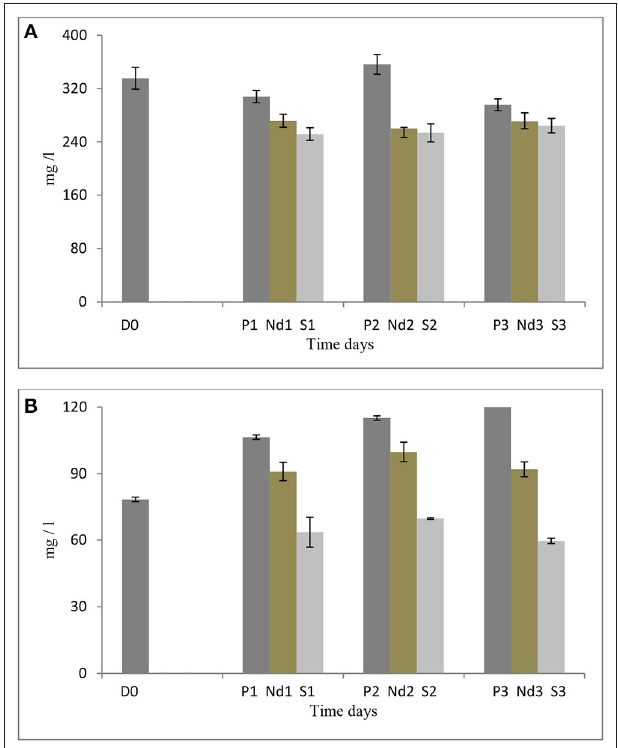
FIGURE 3 | (A) Biomass production of S. dimorphus over time (three days) in prolonged growth, nutrient deprivation and 5% salt stress. (B) Biomass production of S. minutum over time (three days) in prolonged growth, nutrient deprivation, and 5% salt stress. Nutrient deprivation stress was created by using tap water while salt stress was created by using 5% NaCl. Prolonged growth in original wastewater P1, P2, and P3 algae were kept in municipal wastewater were previously have been grown for 6 days. D0 was grown for six days in municipal wastewater before treatment and it represents the start of the experiment. Biomass is reported as dry weight per liter (mg/L). Bars represent the mean ± SE of three